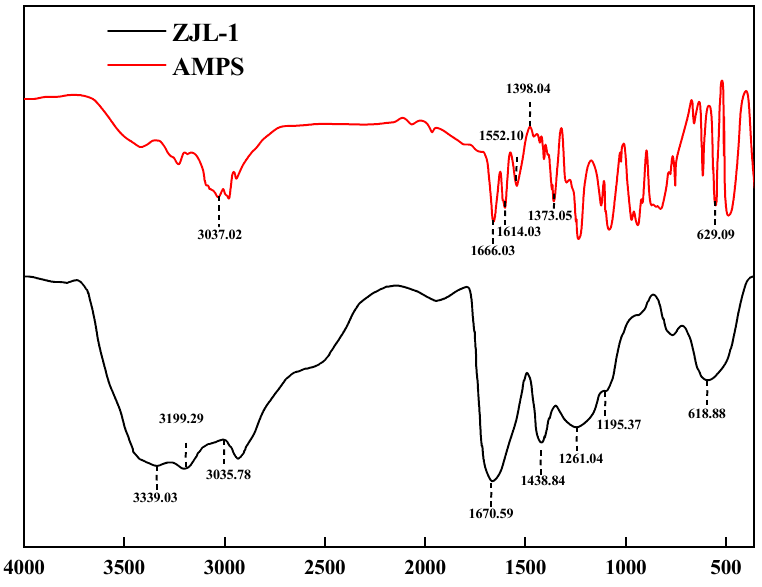
Figure 5. FTIR spectra of AMPS and ZJL-1.